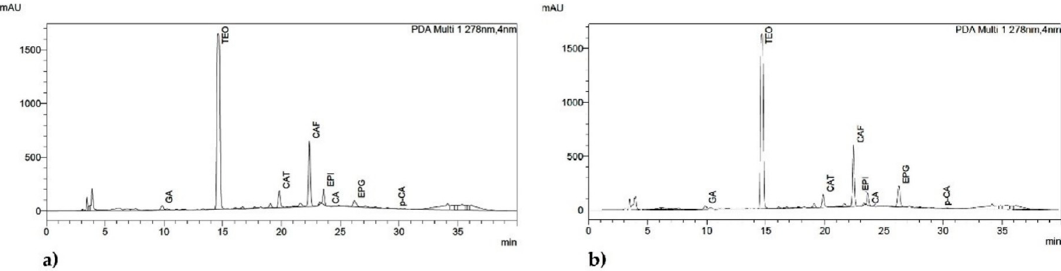
Figure 1. HPLC chromatograms of identified bioactive components in dark chocolate sample ( a ) and dark chocolate with cocoa shell ( b ) recorded at 278 nm. Peaks: GA (gallic acid), TEO (theobromine), CAT (( + )-catechin), CAF (caffeine), EPI (( − )-epicatechin), CA (caffeic acid), EPG (( − )-epicatechin gallate) and p -CA ( p -coumaric acid).